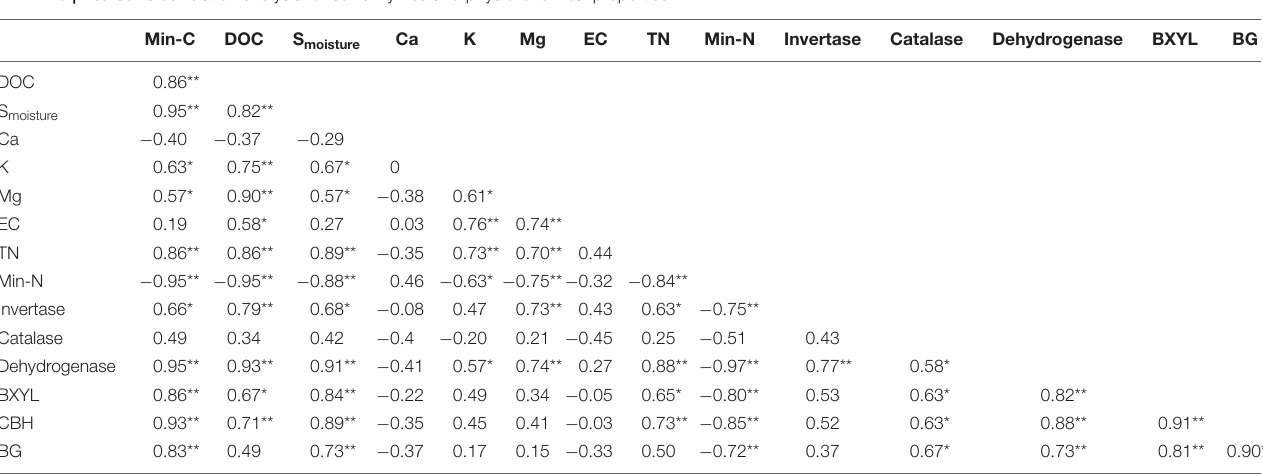
TABLE 3 | Pearson’s correlation analysis for soil enzymes and physio-chemical